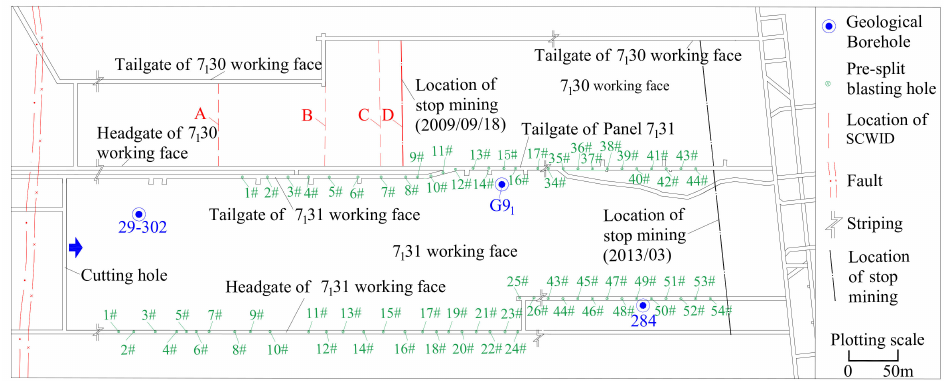
Figure 13. Location of pre-split blasting holes in 7 1 31 working face.